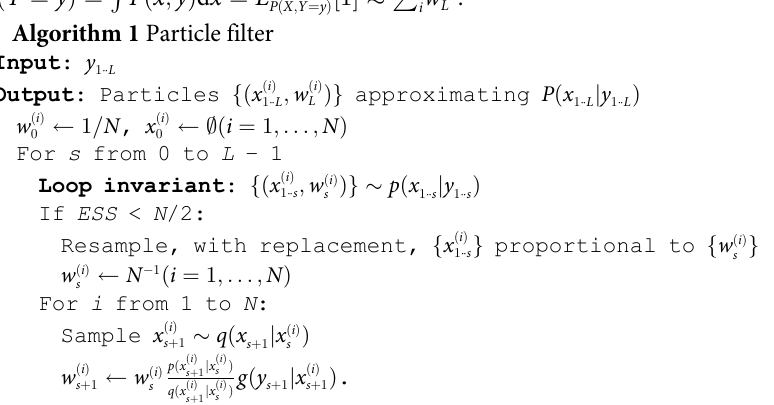
Algorithm 1 Particle